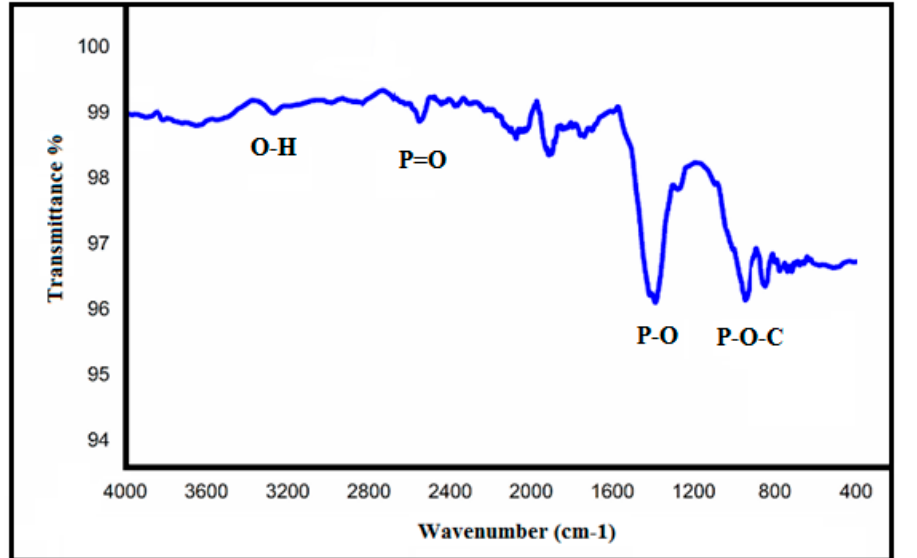
Figure 5. ATR-IR spectra of APBC nanofibers.